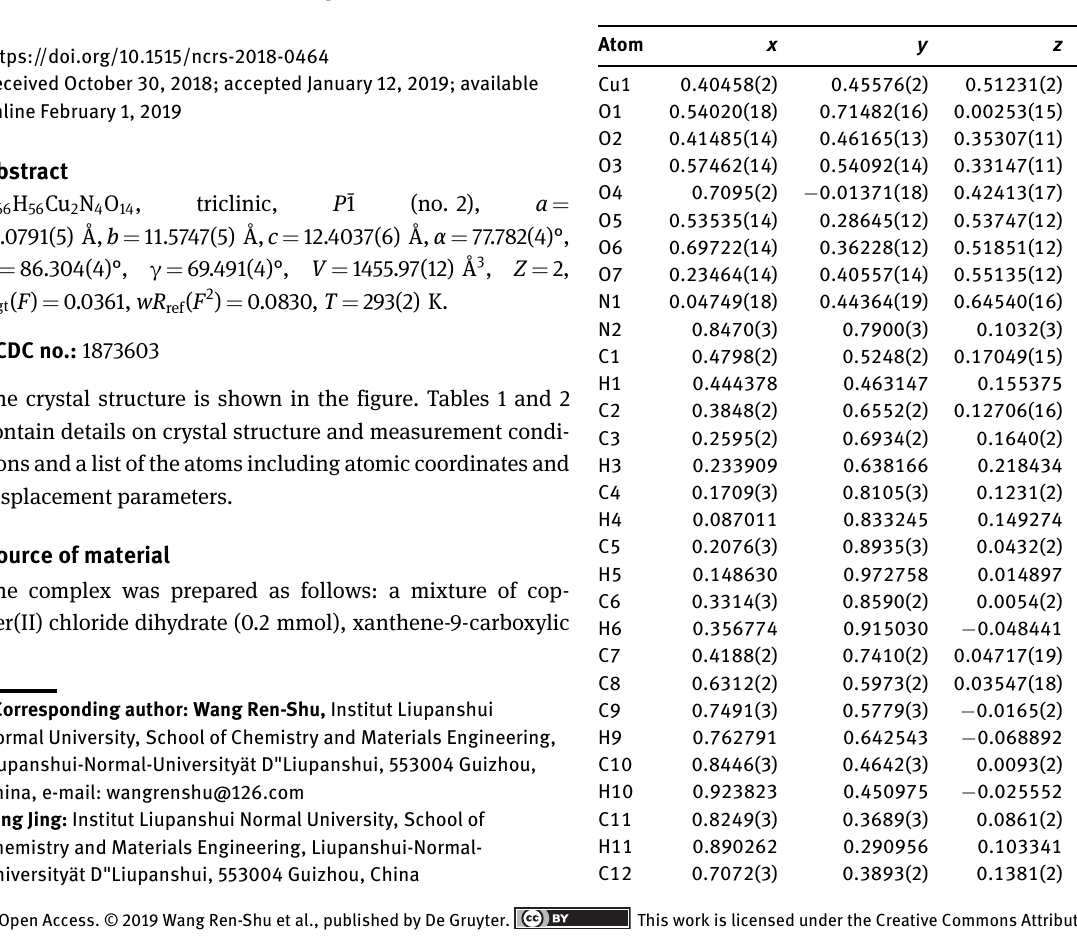
Table 2: Fractional atomic coordinates and isotropic or equivalent isotropic displacement parameters (Å 2